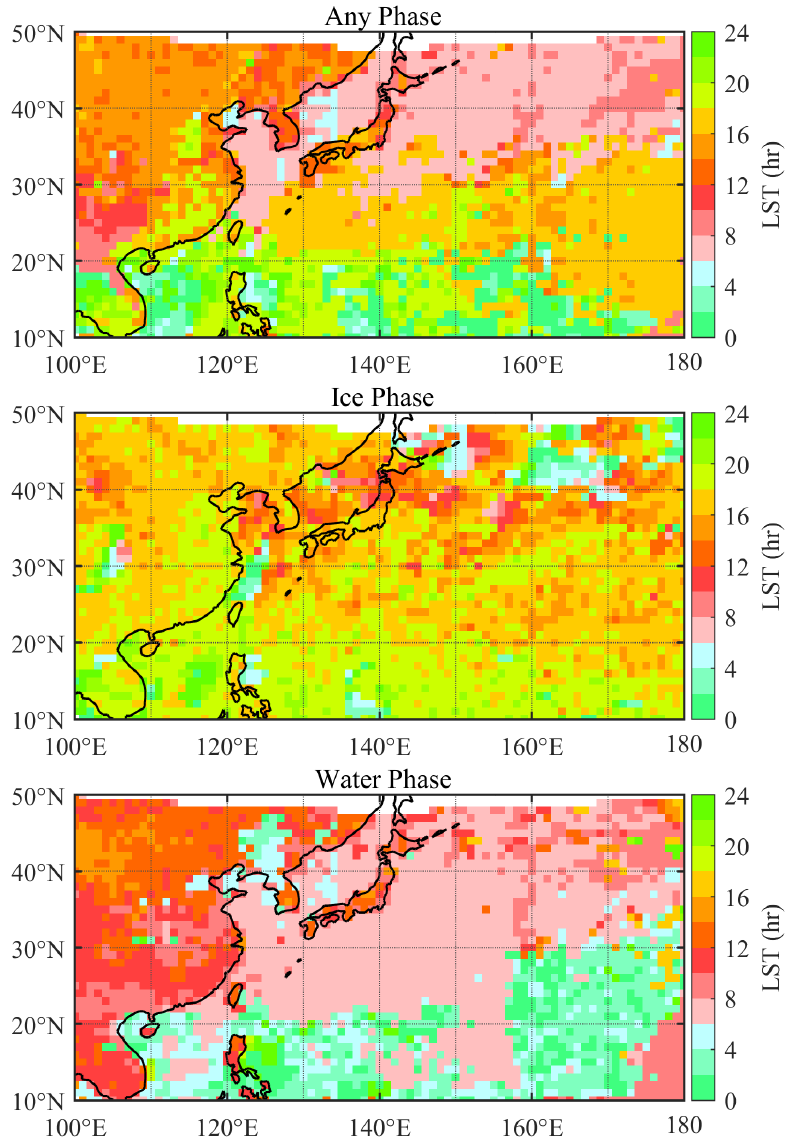
Figure 9. Local solar times (unit: hour) when the frequencies of different cloud-top phases reach their peak values using the 3-year boreal summer data.